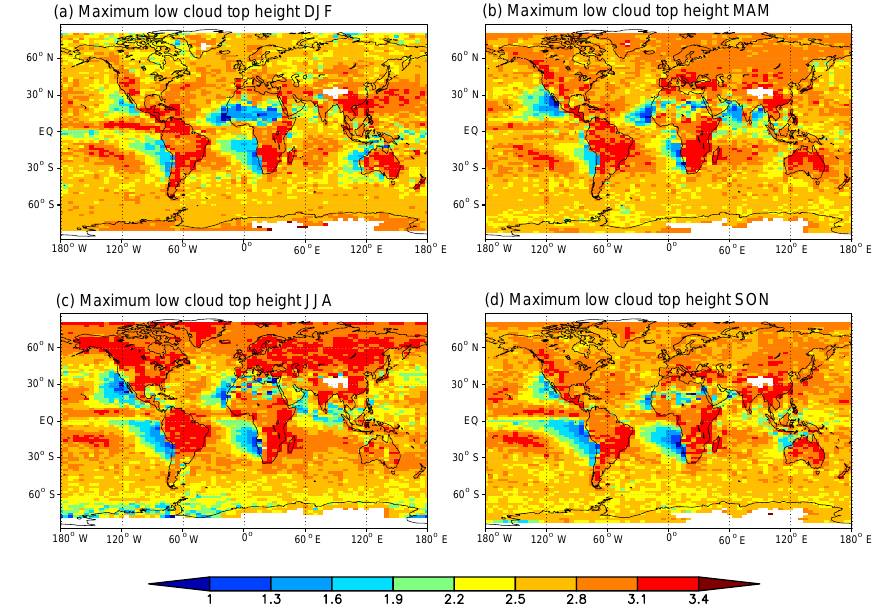
Figure 4. Daytime maximum low-cloud-top height (km) for (a) DJF, (b) MAM, (c) JJA, and (d) SON.